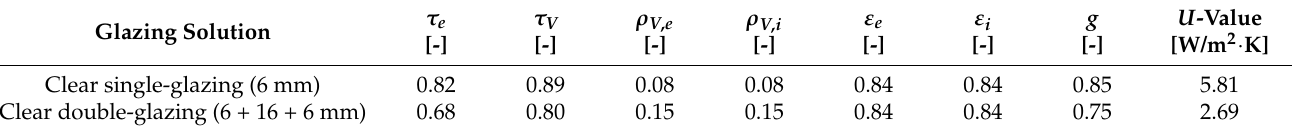
Table 1. Main solar optical and thermal properties of the glazing solutions (clear single and double- glazing) representative of common building glazing: solar transmittance, τ e ; visible light transmit- tance, τ V ; visible exterior reflectance, ρ V , e ; visible interior reflectance, ρ V , i ; external emissivity, ε e ;